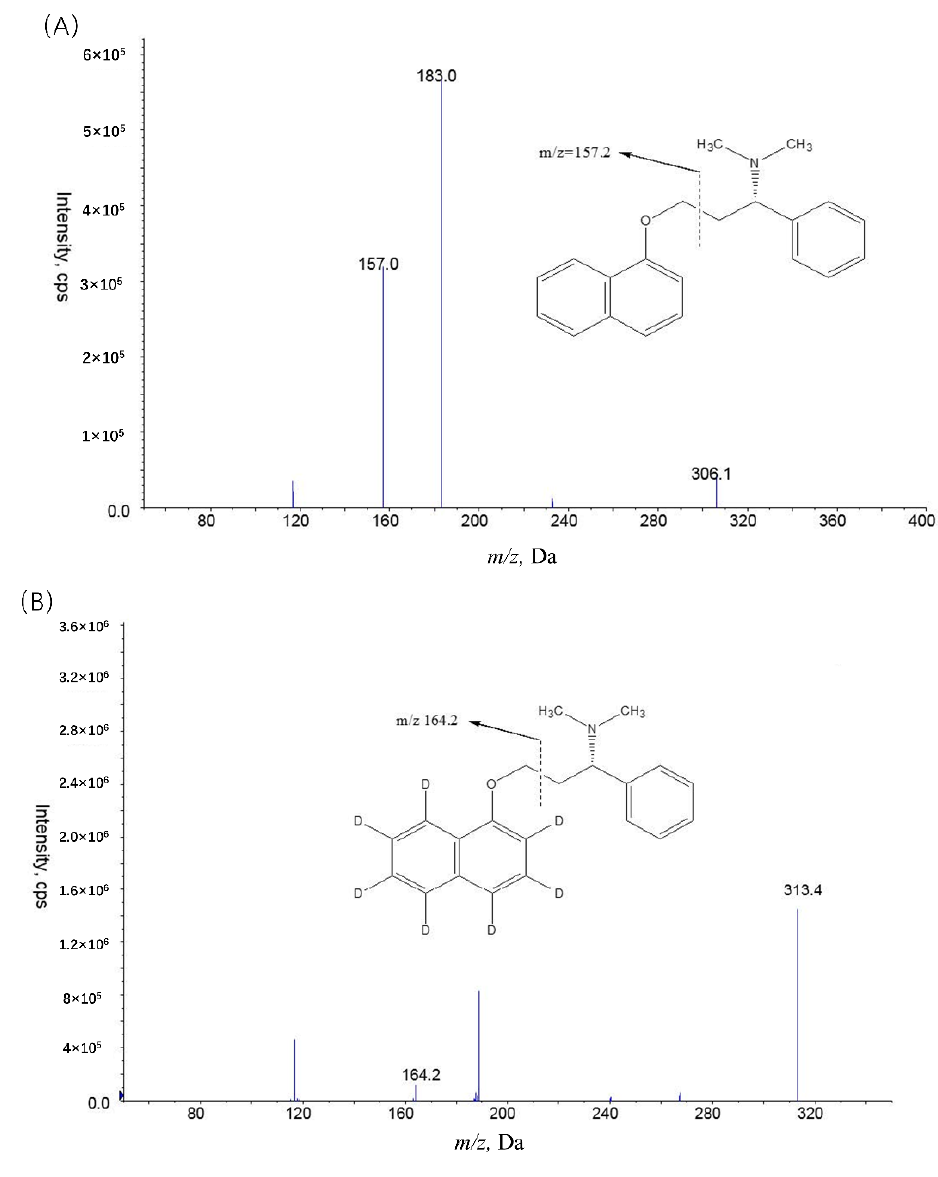
Figure 1. MS/MS spectra of DP ( A ) and IS ( B ) .